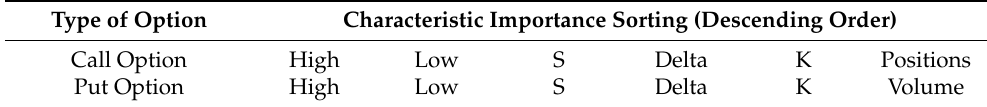
Table 4. Characteristic importance sort table.